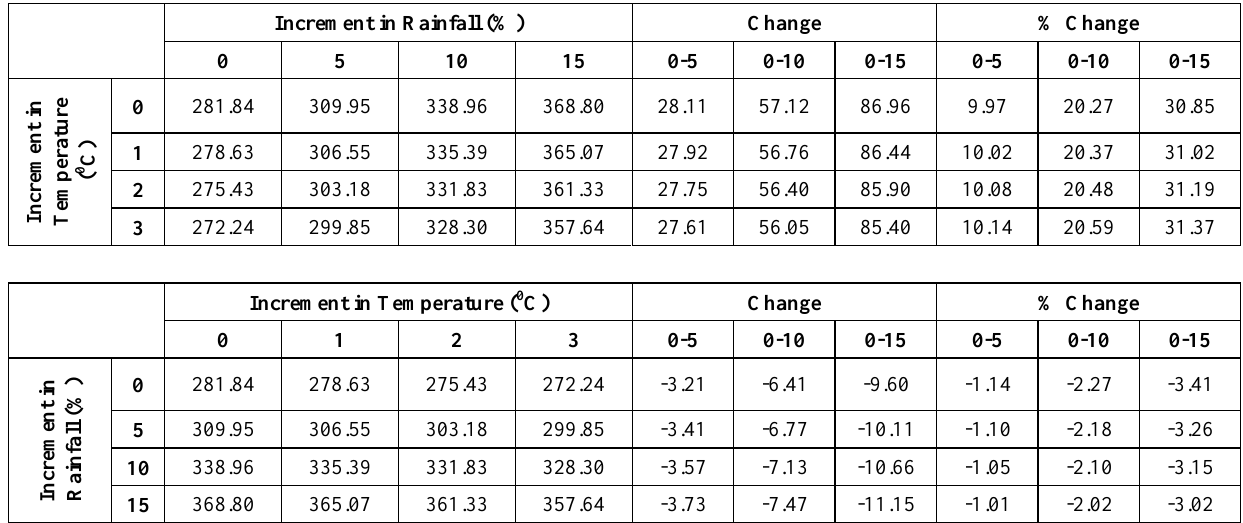
Table 3. Summary of ET estimation analysis of each scenario Increment in Rainfall